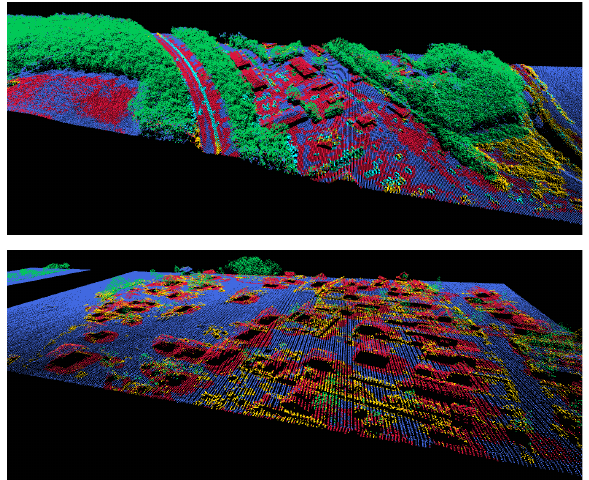
Table 5. MCP (in %) for different neighbourhood definitions and different feature sets.